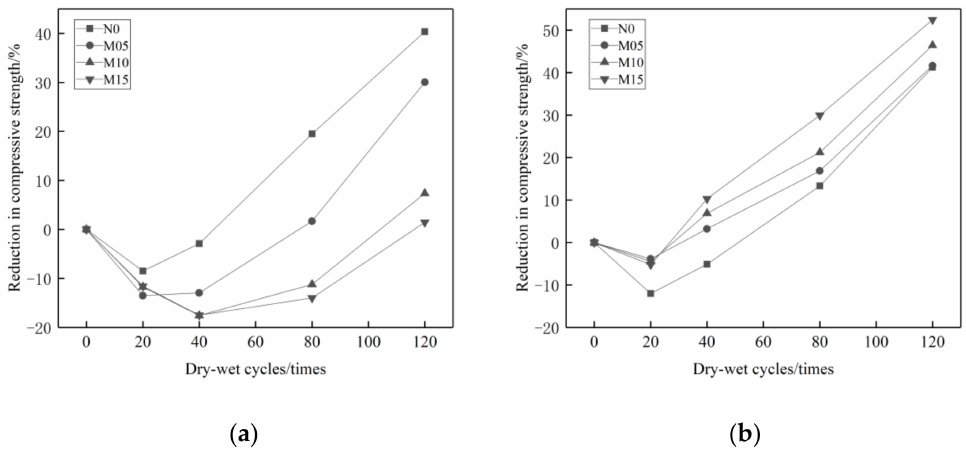
Figure 8. Loss rate of compressive strength of concrete with MK dosage under different erosion conditions. ( a ) 10% Na 2 SO 4 , ( b ) 10% MgSO 4 .